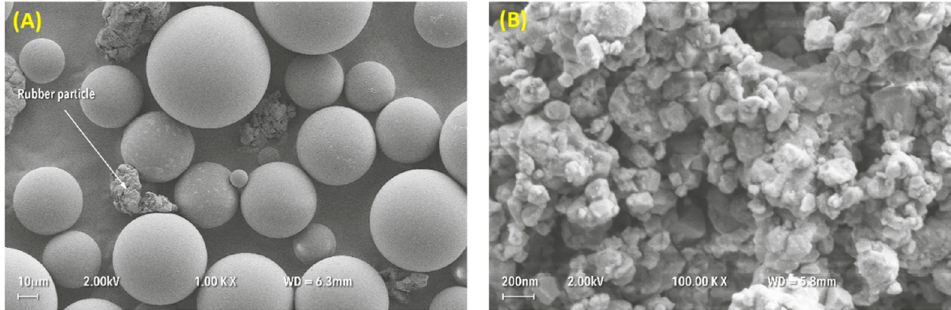
Figure 2. Particle size and shape distributions of ( A ) PMMA powder and ( B ) zirconia